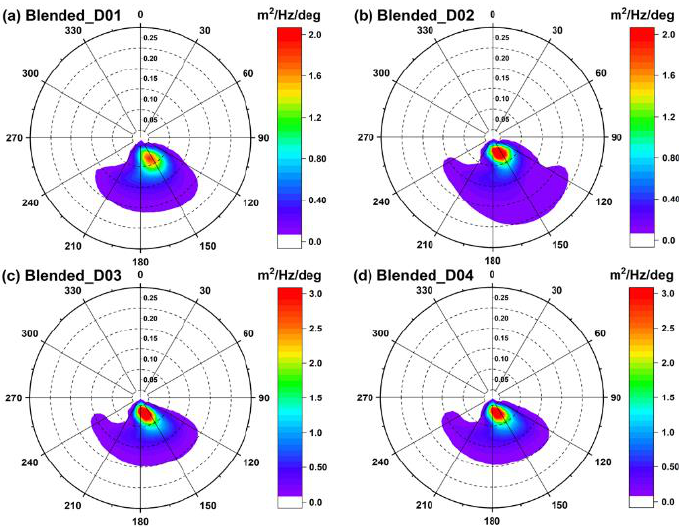
Figure 16. Comparison of the directional wave spectra at the Suao wave buoy at 00:00 on 14 September 2016, using the four computational domains ( a – d ) and blended wind fields.